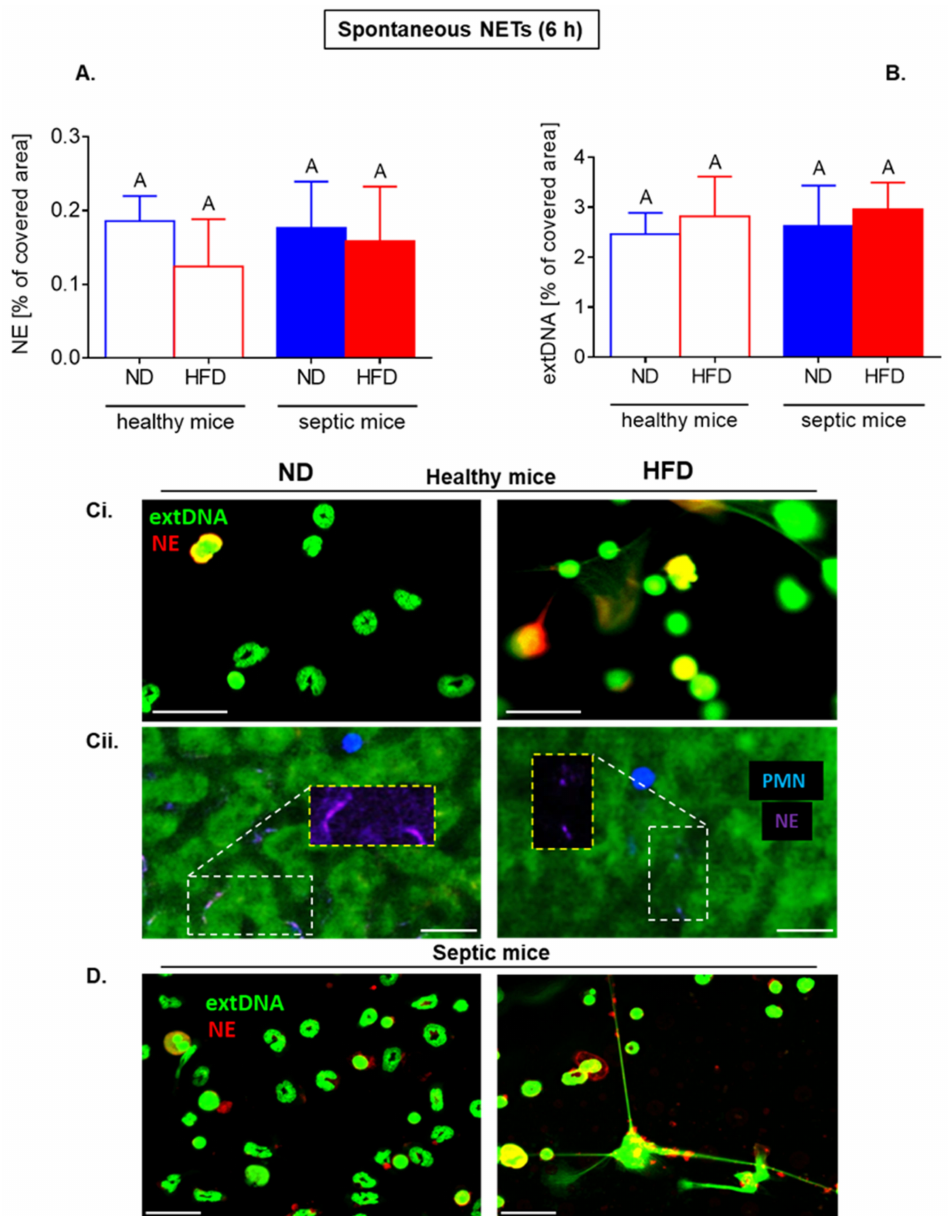
Figure 5. Long-term spontaneous formation of neutrophil extracellular traps (NETs) by neutrophils of mice with obesity induced by high fat diet (HFD) and their lean controls (ND) either ex vivo or in vivo. Studies were performed on either healthy mice (not treated in any way; healthy mice) or with ongoing systemic inflammation/endotoxemia induced 24 h prior to analyses by injecting animals with 1 mg/kg body weight of lipopolysaccharide (LPS; septic mice). Ex vivo NET formation was evaluated 6 h after cell seeding without any further stimulation ( A – C ). NET quantification: area [%] covered by neutrophil elastase (NE) ( A ) and extracellular DNA (extDNA) ( B ) Representative images from ex vivo studies: immunocytochemical counterstaining of neutrophil elastase (NE, red) along with extracellular DNA staining (extDNA, green). Scale bar indicates 25 µ m ( Ci , D ). Additionally, in vivo NET formation in liver vasculature was estimated in healthy untreated mice ( Cii ). On images neutrophil elastase (NE, violet) is visible lining along sinusoids (black ducts) which are localized in between autofluorescent hepatocytes (dim green). White dashed line denotes regions rich in neutrophil elastase. Areas are additionally shown in Cy5 channel (NE signal) only (yellow dashed line). Neutrophils are denoted in blue. Scale bar indicates 25 µ m ( Cii ). Results of one-way ANOVA (post hoc Bonferroni): means that share same letter are not significantly different. Unpaired two-tailed Student’s t -test did not reveal any differences between